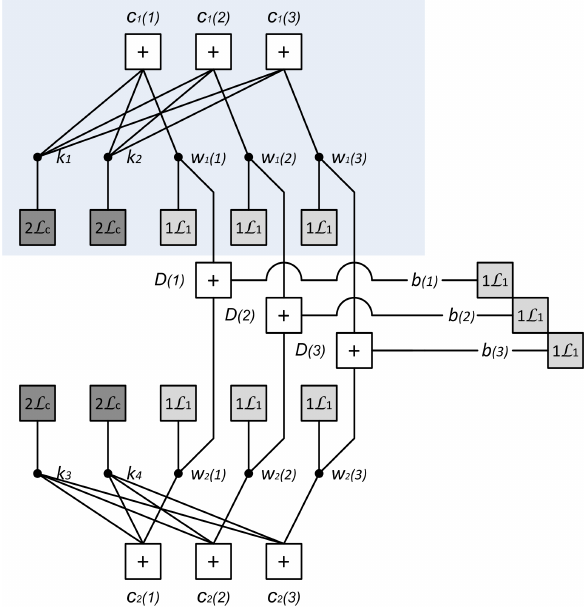
Figure 2: Example of factor graph corresponding to Figure 1 ( N =